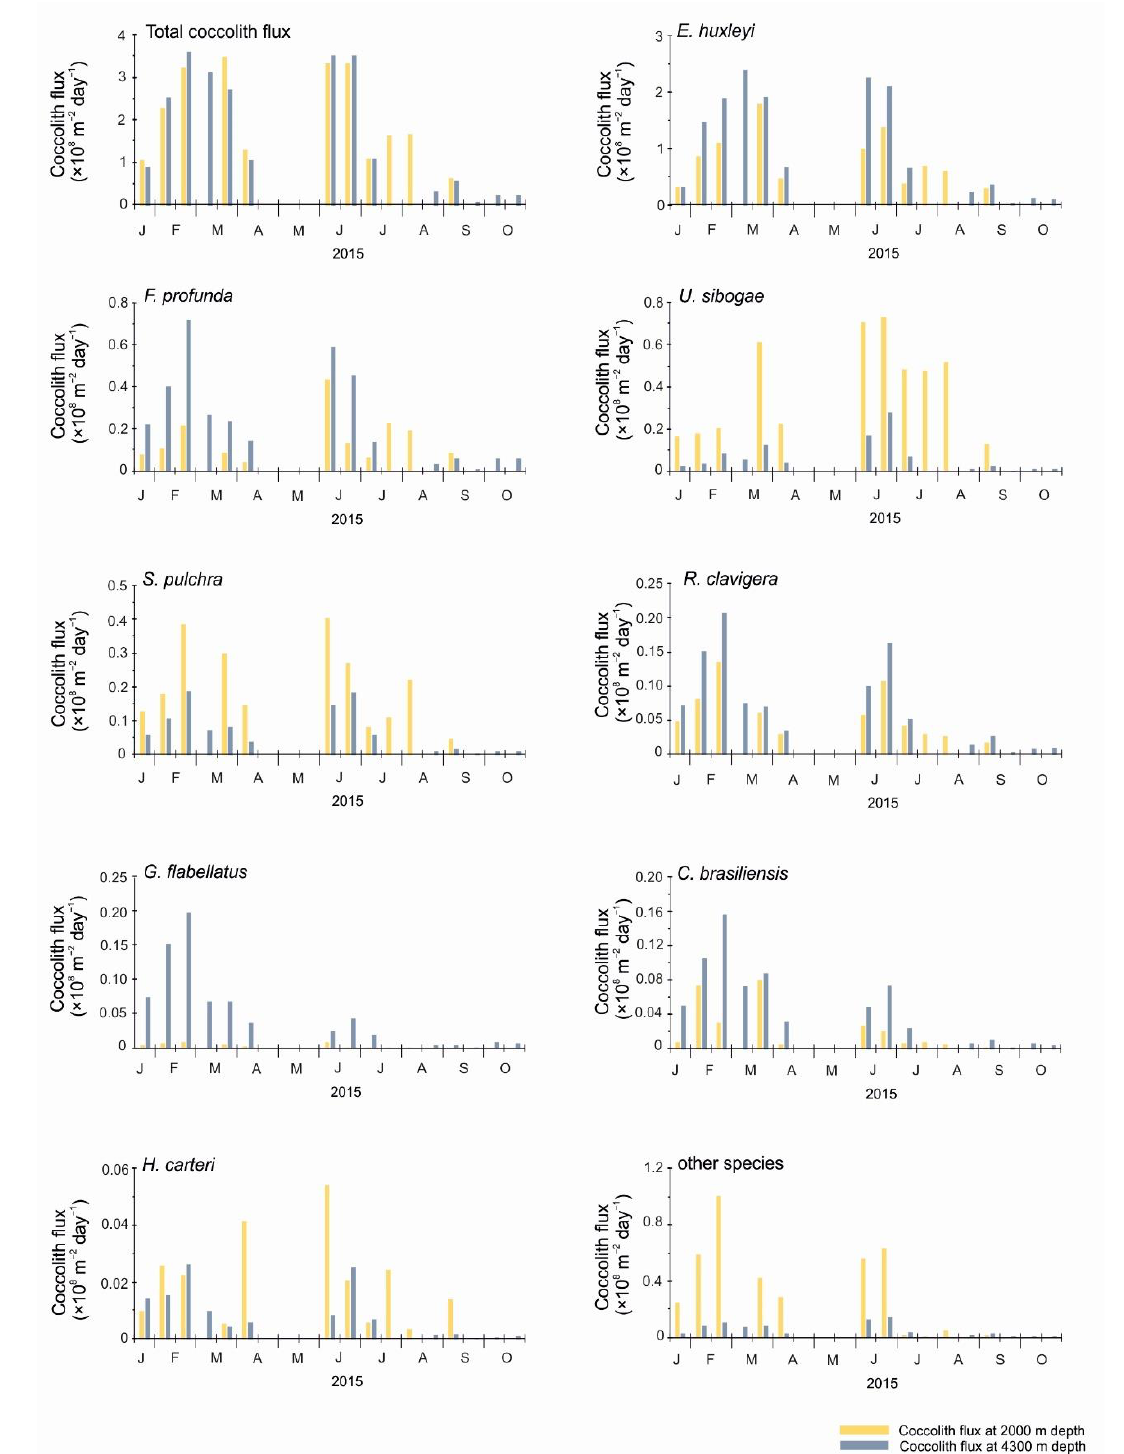
Figure 4. Comparison of the total and major species coccolith fluxes recorded at 2000 m [13] with their fluxes at 4300 m during the 2015 annual cycle sampling interval at Nestor site (2000 m [13] and 4300 m, present study). The total and major species coccosphere units from 2000 m depth (data from Skampa et al. [13]) were converted to coccoliths following the method by Boeckel and Baumann (2008) [52] and were incorporated to the coccolith fluxes at 2000 m depth.